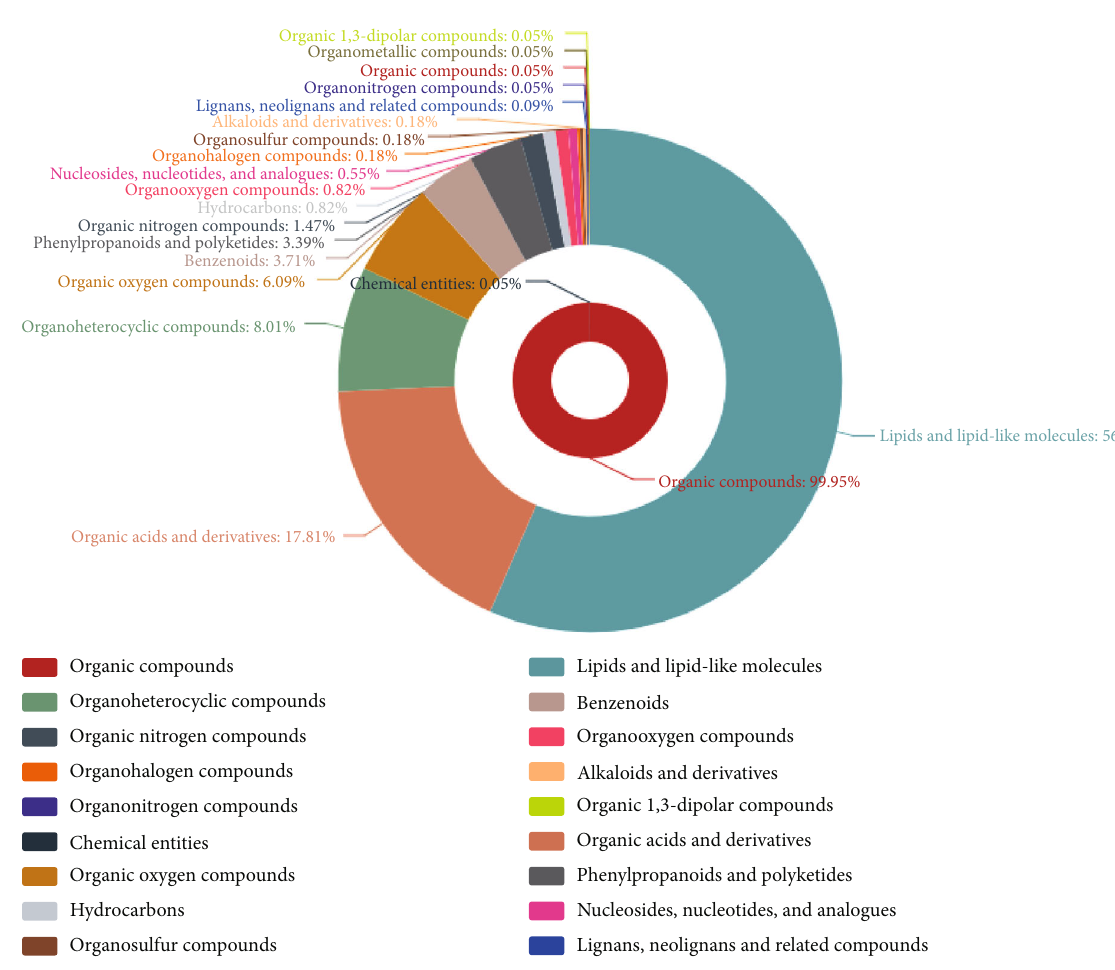
Figure 2: Classi fi cation of extracellular metabolites of Bacillus